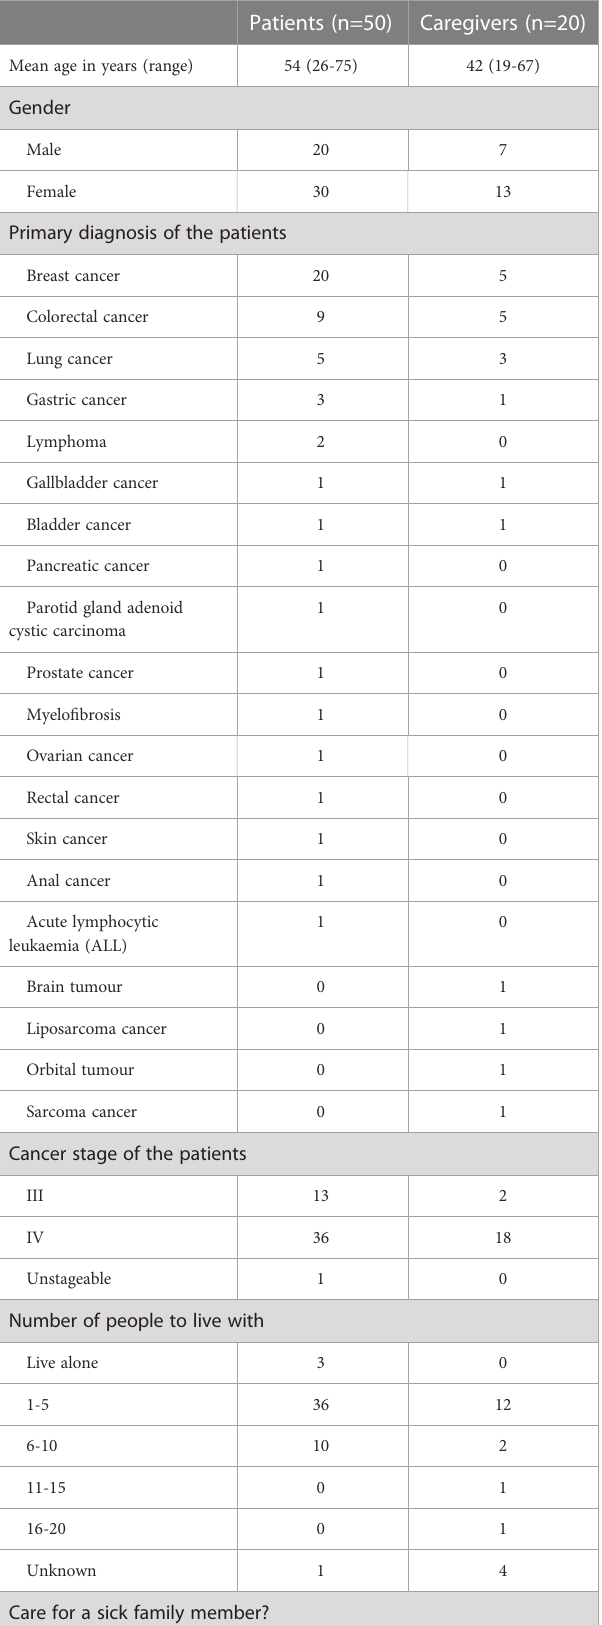
TABLE 1 Participant characteristics